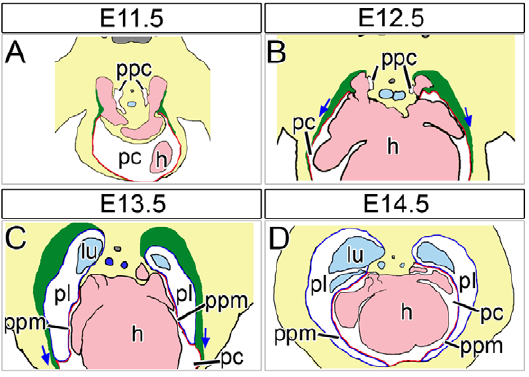
Figure 1. Schematic diagram of murine PPM development. (A– D) Scheme of PPM development based on transverse sections through the cardiac venous pole of wildtype embryos from E11.5 to E14.5. The lumen of the caval veins and the heart is marked in pale pink, the lung and trachea in pale blue, the (parietal) pleura in blue, the (parietal) pericardium in red, and the degenerating subcoelomic mesenchyme in green. Blue arrows demonstrate the direction of the detachment of the PPMs from the subcoelomic mesenchyme. Note the PPMs are double- layered consisting of the parietal layer of the pleura and the pericardium. Dorsal is up, ventral is down. h, heart; lu, lung; pc, pericardial cavity; pl, pleural cavity; ppc, pericardioperitoneal canal; ppm, pleuropericardial